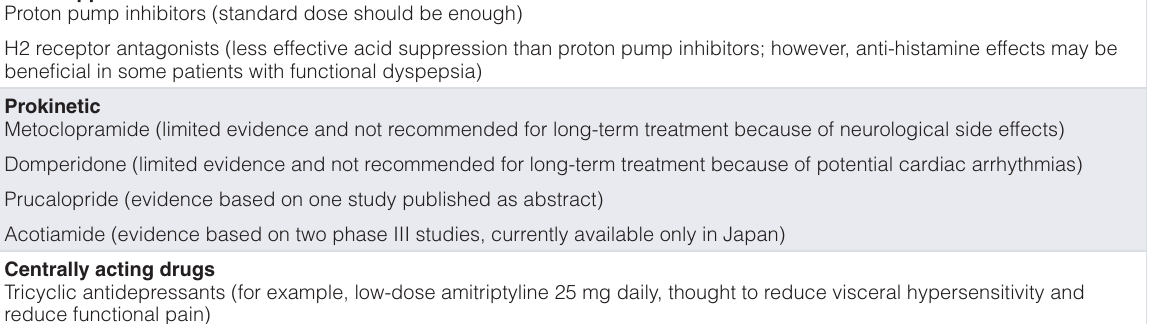
Table 2. Pharmacological treatment options for functional dyspepsia. Acid suppression Proton pump inhibitors (standard dose should be